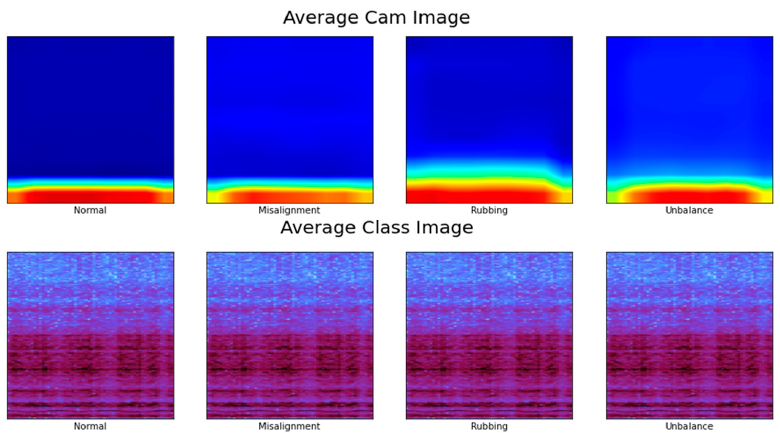
Figure 9. Visualization result of Class Activate Map (CAM) ( Up ) and image average ( Down ) for each class derived from the model learned in this paper. There is no noise data, so you can see it comes out cleanly.